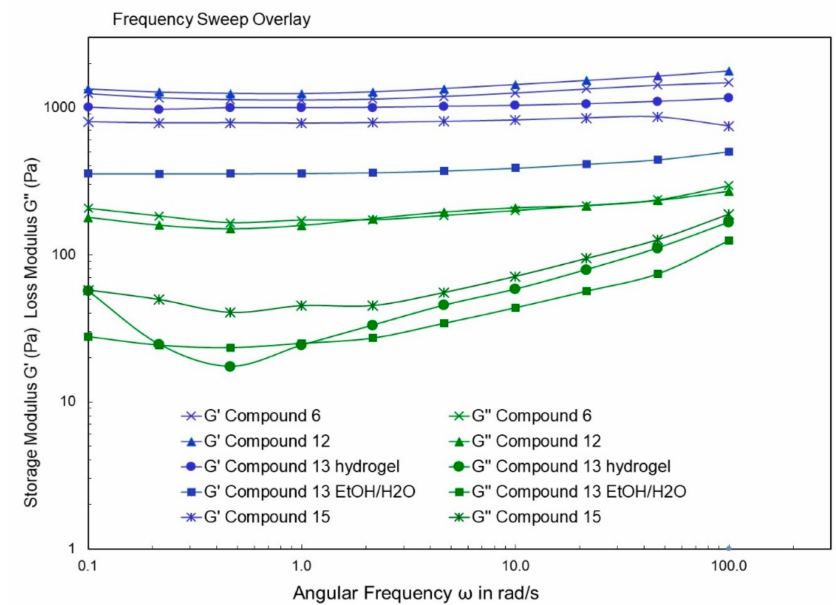
Figure 8. Rheological properties of the gels formed by several gelators at their MGCs: compound 6 in EtOH/H 2 O (1:1) at 0.74 mg/mL; compound 12 in EtOH/H 2 O (1:1) at 0.67 mg/mL, compound 13 in water at 0.36 mg/mL and in EtOH/H 2 O (1:2) at 0.36 mg/mL and compound 15 in DMSO/H 2 O (1:1) at 0.71 mg/mL. All frequency sweeps were using 0.1%